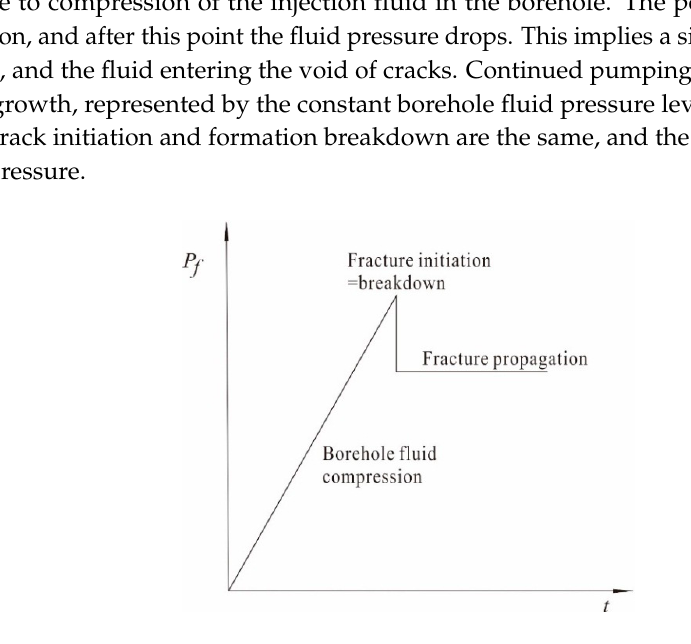
Figure 6. Idealized borehole fluid pressure response during hydraulic fracturing.